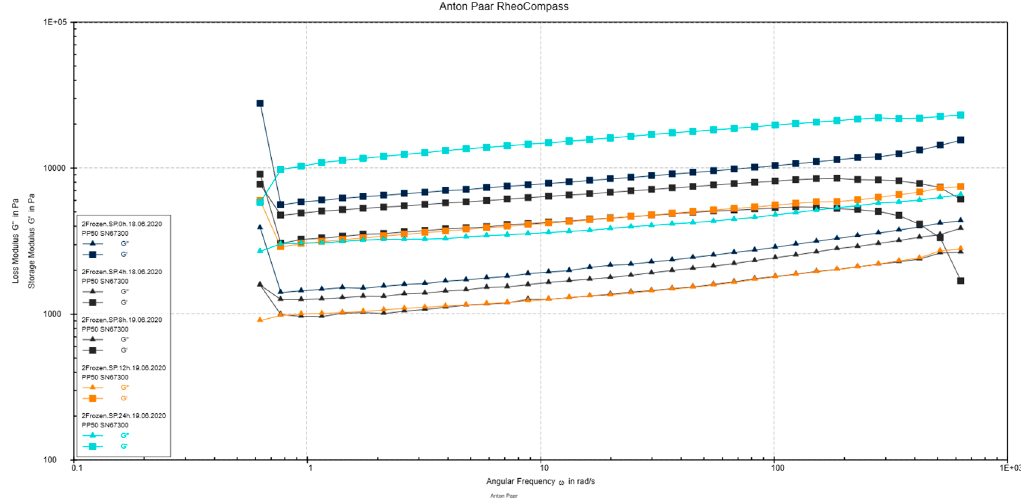
Figure 5. The storage (G’) and loss (G”) shear moduli for SP forzen sourdough at different fermentation times: 0, 4, 8, 12, and 24 h.